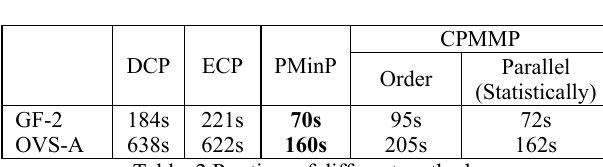
Table. 2 Runtime of different